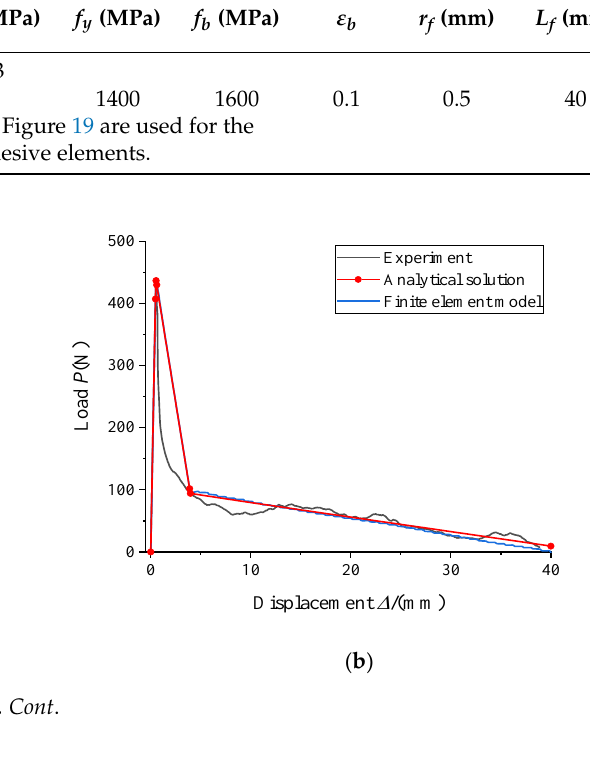
The curves in Figure 19 are used for the Figure 20. The finite element model of single pullout tests. cohesive elements.